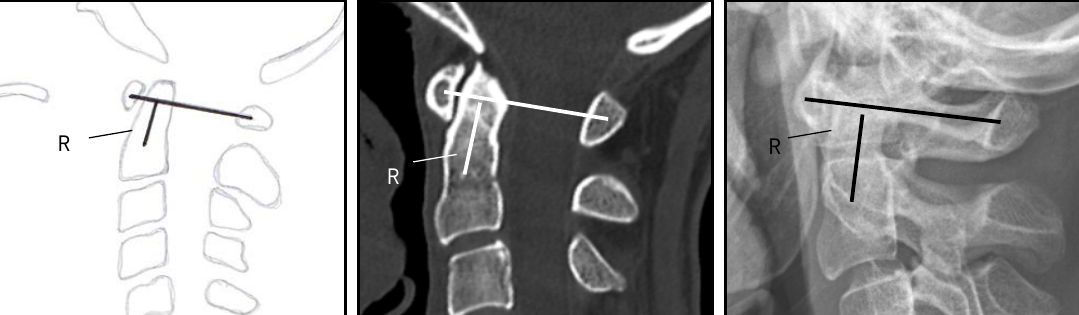
Figure 1. Ranawat criteria: Line from the center of the anterior C1 arch to the center of the posterior C1 arch. A second line goes through the axis from the odontoid to the center of the base of the C2. The smaller the distance (R) to the crossing of the lines, the more pronounced the invagination. A distance > 13 mm for women and > 15 mm for men is normal [8].